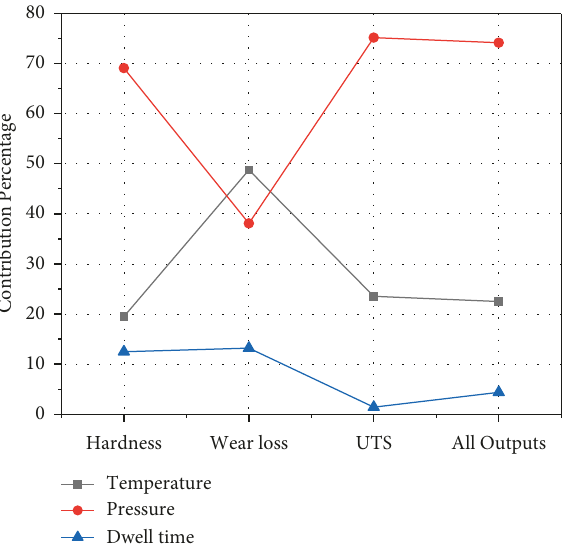
Figure 12: Hot-pressing constraint’s percentage of contribution. Table 12: Evaluation of Variant processing methodology Characteristics. Optimal characteristics of variable